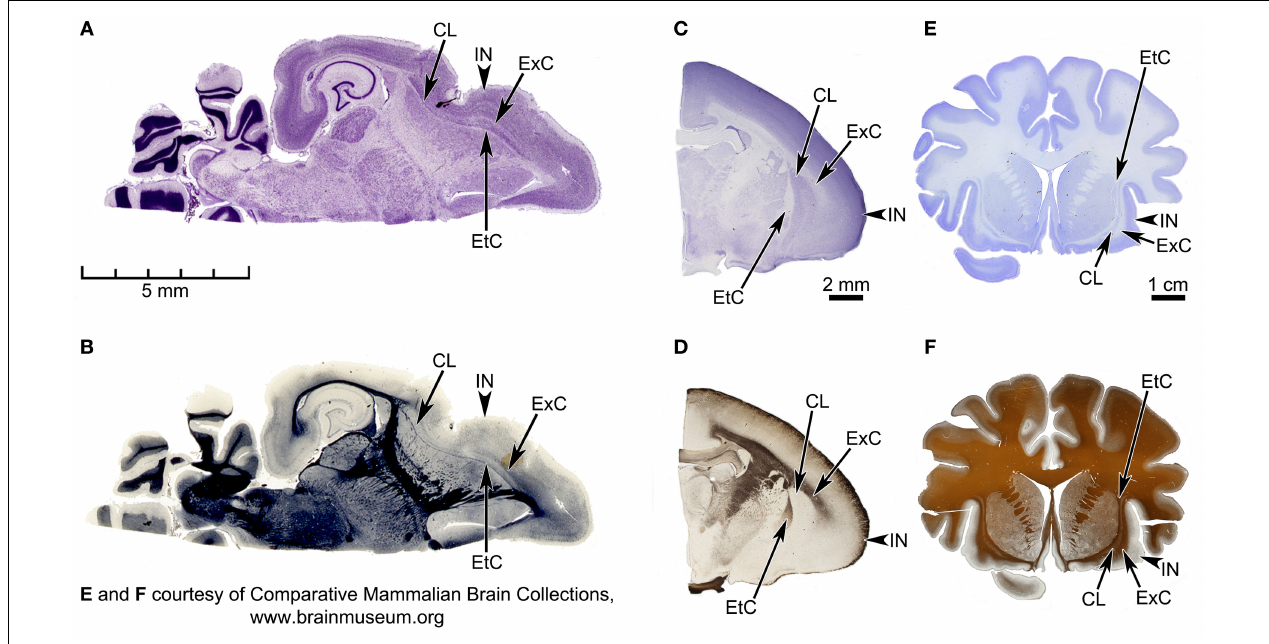
are labeled. In the tarsier, the claustrum and the insula, while clearly segregated in the dorsal halves, appear fused together in the ventral portions. On the other hand, the extreme capsule in the orangutan is very extensive, completely separating the two structures. In the Microcebus the claustrum and the insula are extremely close together. Also, whereas the external capsule is relatively well defined throughout its entire length, the extreme capsule is almost absent in some parts. (A,B) Courtesy of the Comparative Mammalian Brain Collections (http://www.brainmuseum.org/), a collaborative effort among the University ofWisconsin-Madison, Michigan State University, and the National Museum of Health and Medicine, funded by the National Science Foundation and the National Institutes of